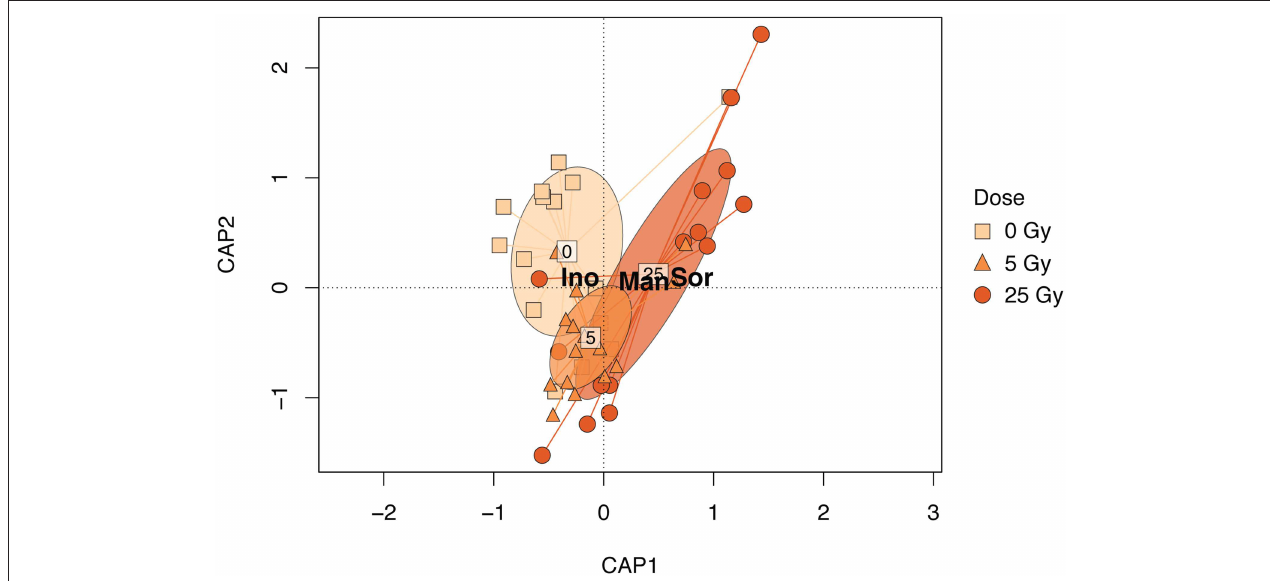
FIGURE 3 | CAP biplot based on the relative metabolite concentration matrix of E. magnus constrained by dose. Points represent individual samples and are shaped and colored by exposure (see figure legend). The ellipsoids represent the standard deviation for each exposure. The metabolites shown in the figure—Sor (sorbitol), Man (mannitol), and Ino (scyllo- inositol)—contributed 80% to the dissimilarity as identified in the SIMPER analysis ( Table S2 ).